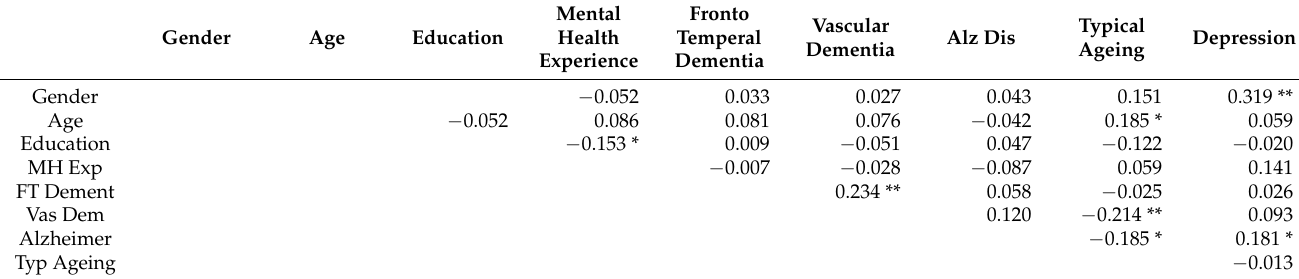
Table 1. A correlation matrix of the identification of the five vignettes and demographics of the participants.